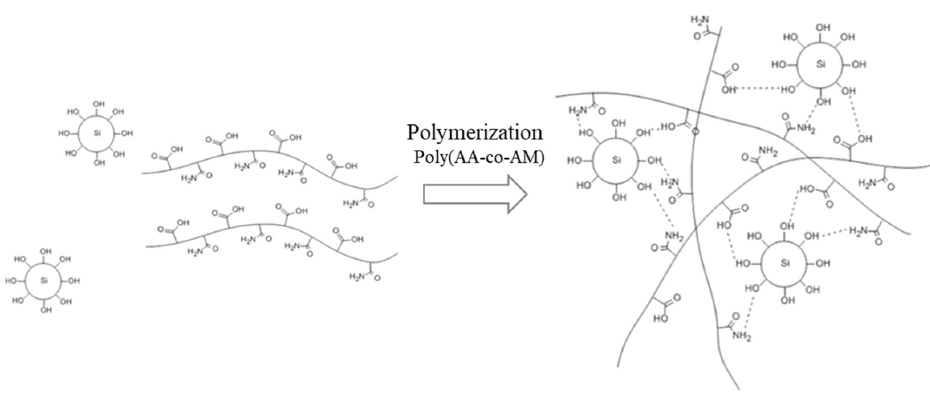
Figure 1. Reaction mechanism of the polymer aqueous solution stabilizer.